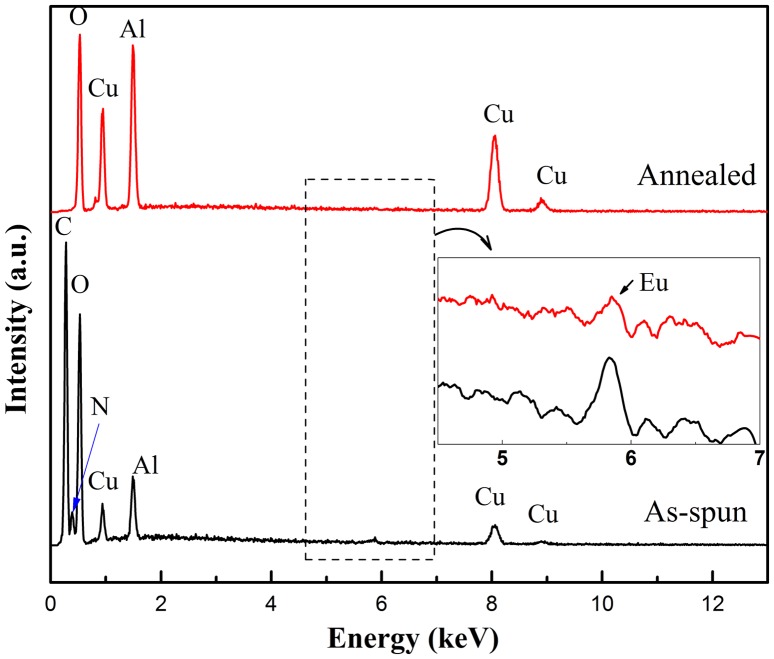
EDS spectra of as-spun polymeric fibers and annealed CuAl0.99Eu0.01O2 ceramic fibers. The enlarged inset shows the presence of Eu.